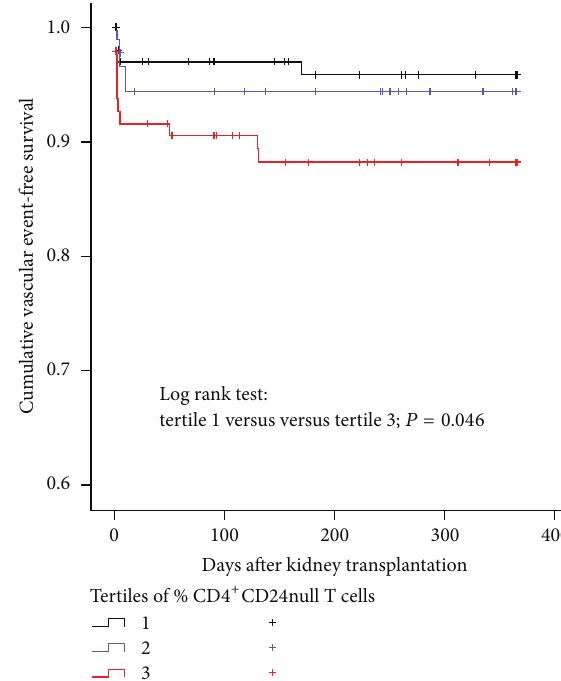
Figure 1: Kaplan-Meier vascular event-free survival after kidney transplantation stratified per tertile of percentage CD4 + CD28null T cells in 290 kidney transplant patients. Range of percentage of CD4 + CD28null T cells in tertile 1: 0.00–0.30%, tertile 2: 0.31–5.16%, and tertile 3: